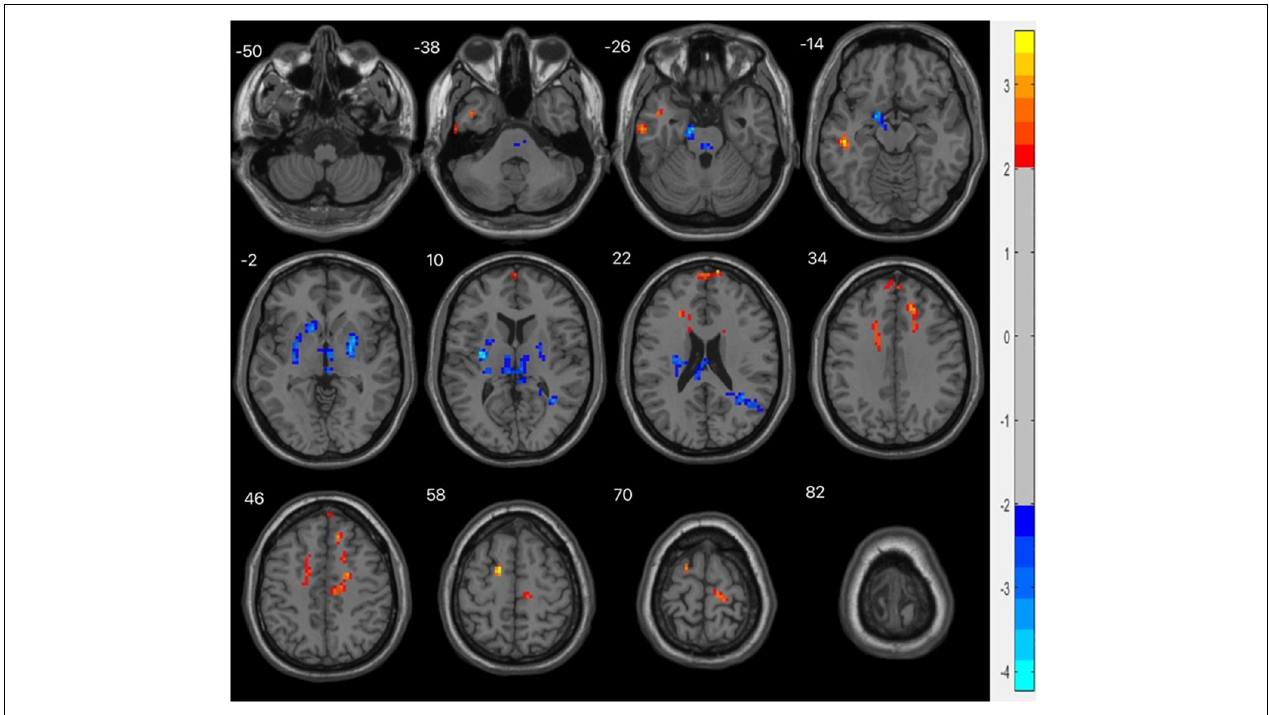
FIGURE 4 | fMRI shows brain regions with abnormal ReHo values in the MDD group compared with the HC group. The chromatographic value in the figure is the t value, indicating the level of ReHo. The red is the area where the ReHo value is significantly increased, and the blue is the area where the ReHo value is significantly decreased.